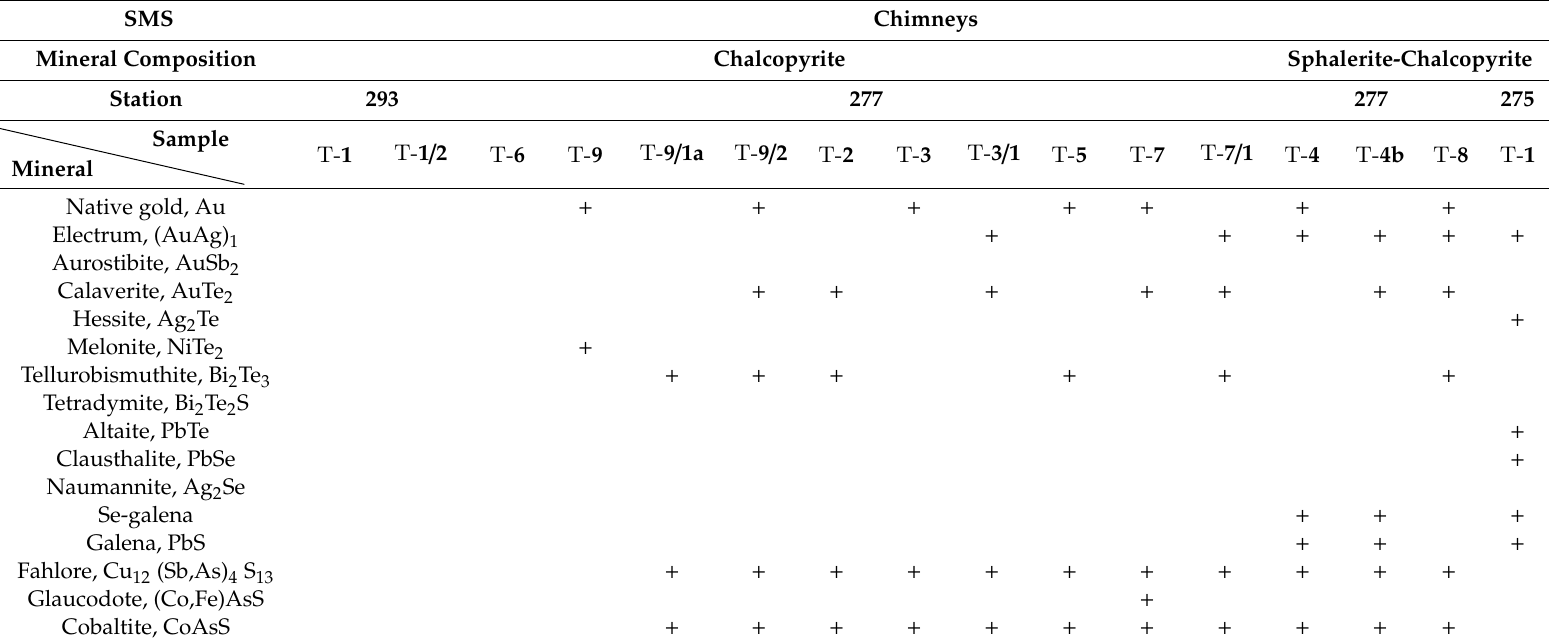
Table 3. Minerals of rare elements in SMS of Semyenov-2 hydrothermal